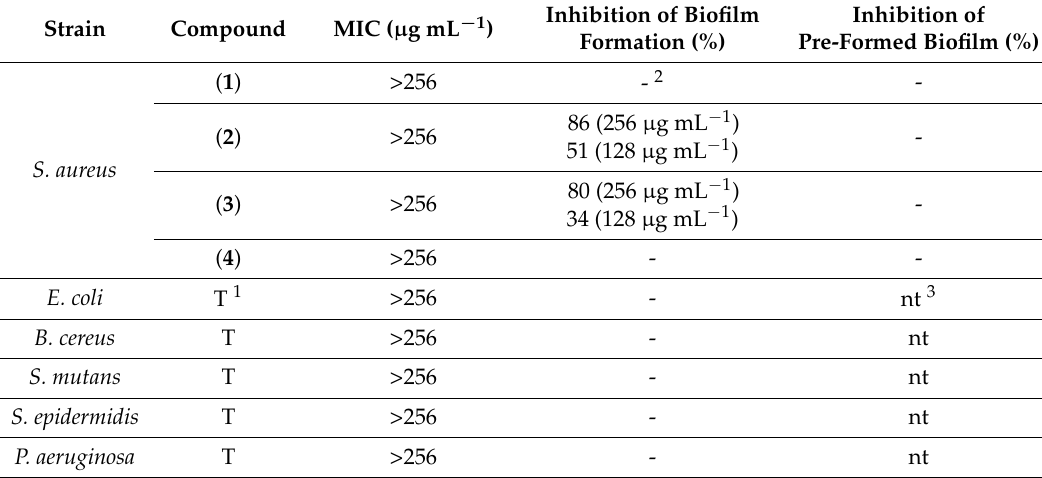
Figure 2. Inhibition of the biofilm formation from S. aureus of compound ( 2 ) ( a ) and ( 3 ) ( b ). Each column has three replicates in different concentrations of the compounds (256, 128, 64, 32, 16 and 8 µ g mL − 1 ) and their respectively controls. C+: Positive control with tetracycline (100 µ g mL − 1 ). C − : Negative control with methanol 3%. Table 2. Antimicrobial MIC and biofilm inhibition.